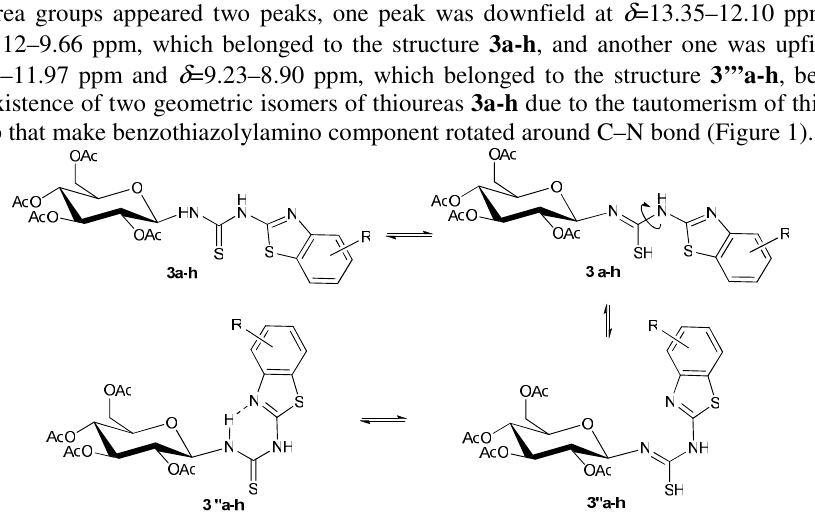
Figure 1. Possible tautomeric forms of N -(tetra- O -acetyl- β - D -glucopyranosyl)- N